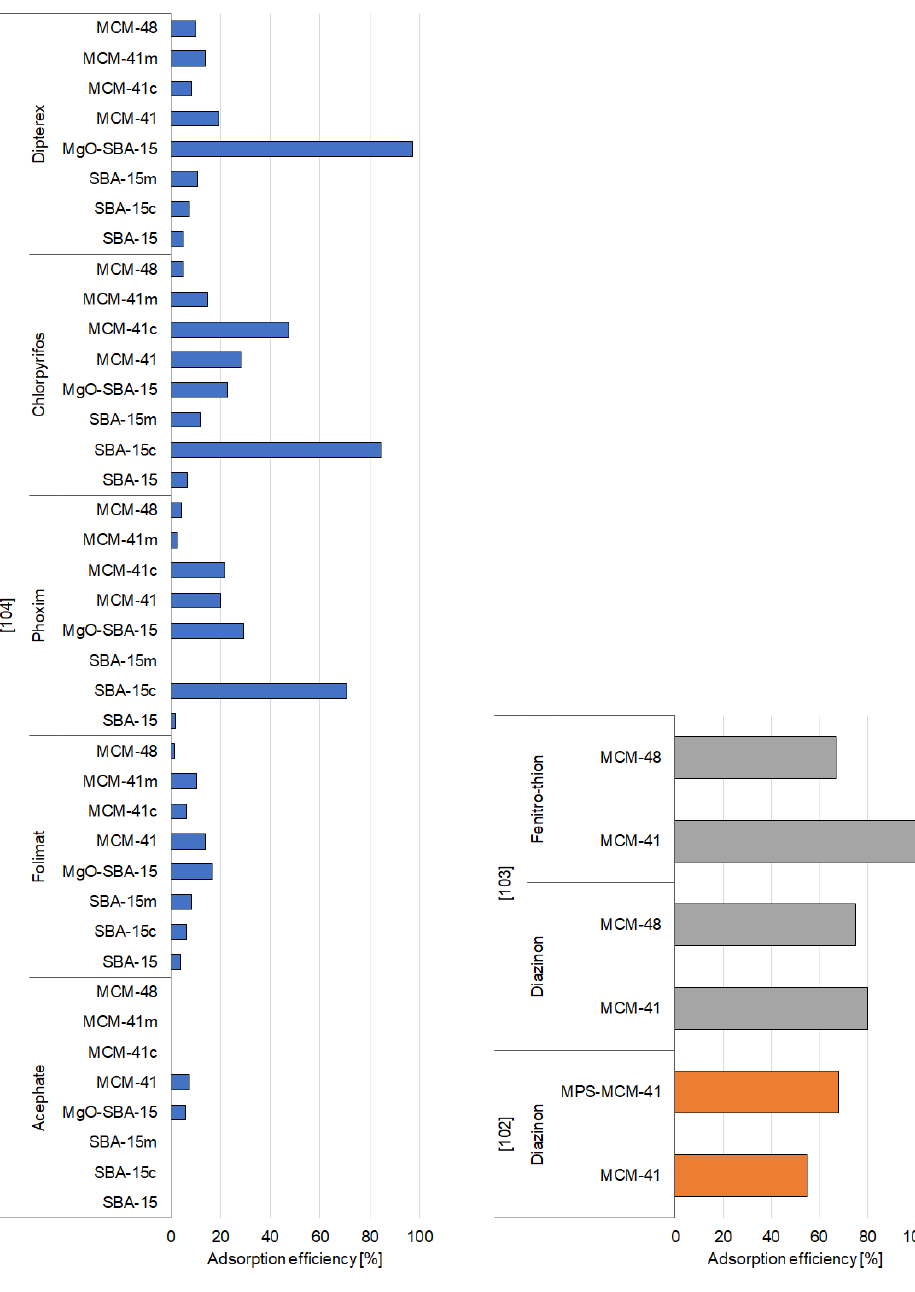
Figure 3. Effectiveness of removal of organophosphorus pesticides by mesoporous silica materials.